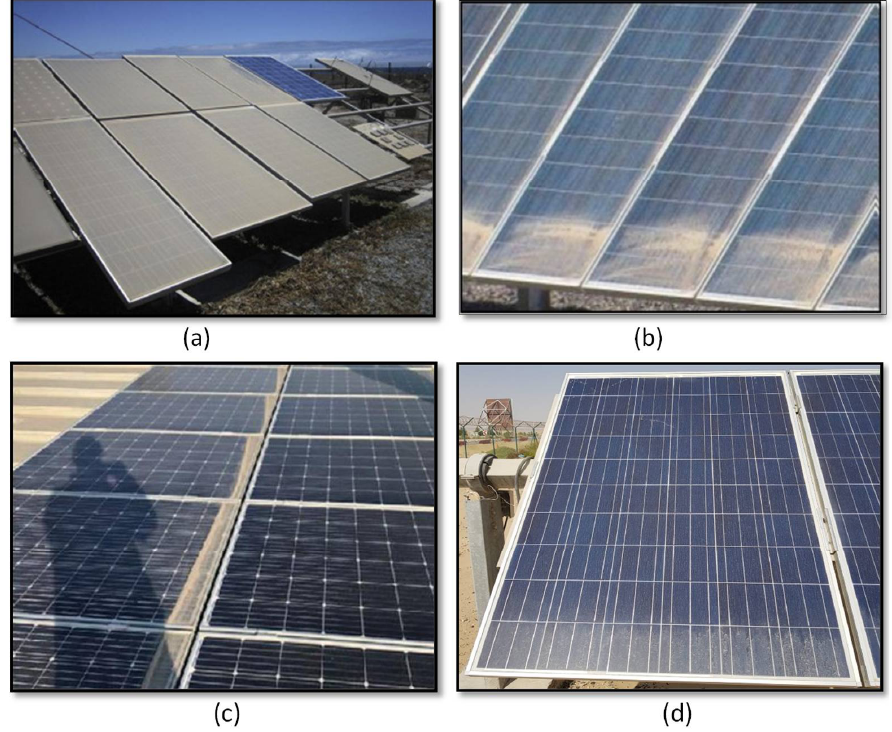
Figure 13. ( a ) Homogeneous soiling in Gran Canaria, Spain (Reprinted with permission from [77]), and inhomogeneous soiling of PV modules mainly in lower parts of the PV modules in ( b ) United States (Reprinted from the presentation in the conference related to [78]), ( c ) Xi’an, China (Reprinted with permission from [79]), and ( d ) Dubai, United Arab Emirates.